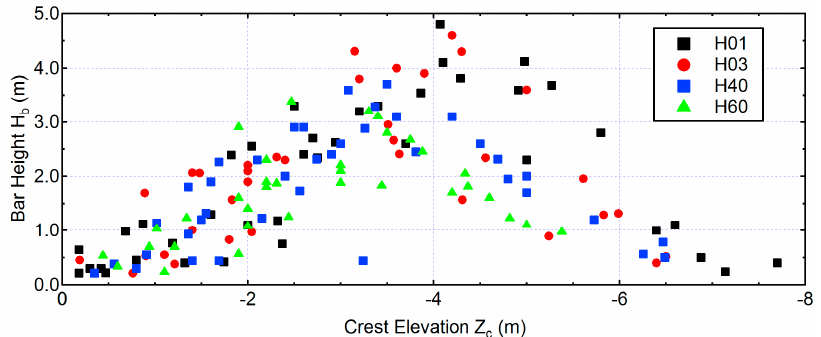
Figure 12. Relationship between bar height and crest elevation.